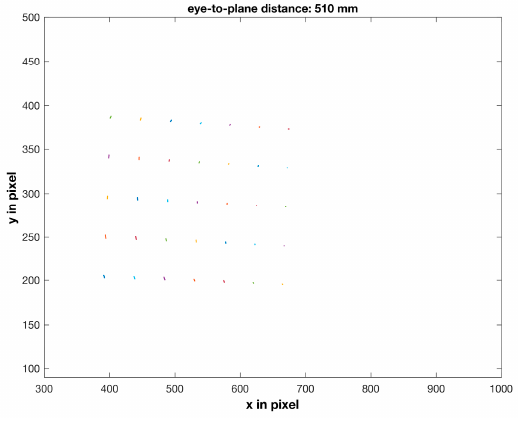
Figure A6. Map of disparities for a target plane placed at 510 mm from the observer.